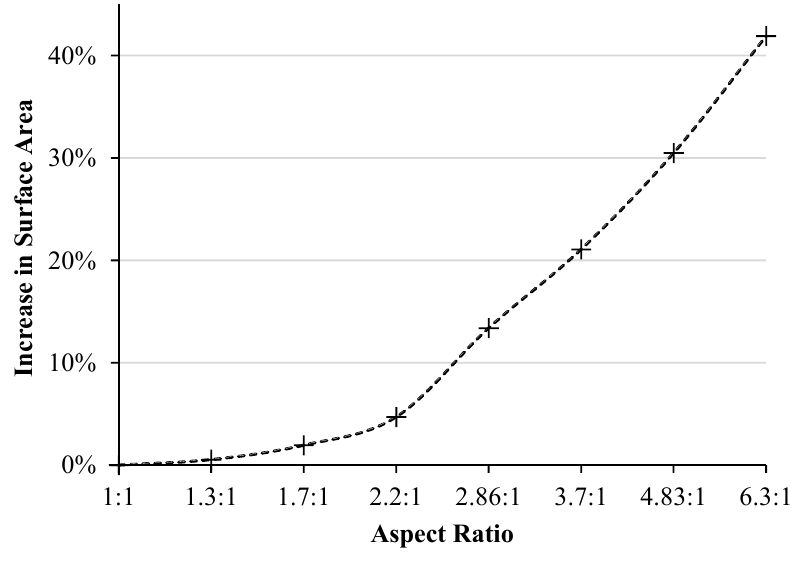
Figure 4. Increase in exterior surface area relative to a 1:1 aspect ratio.